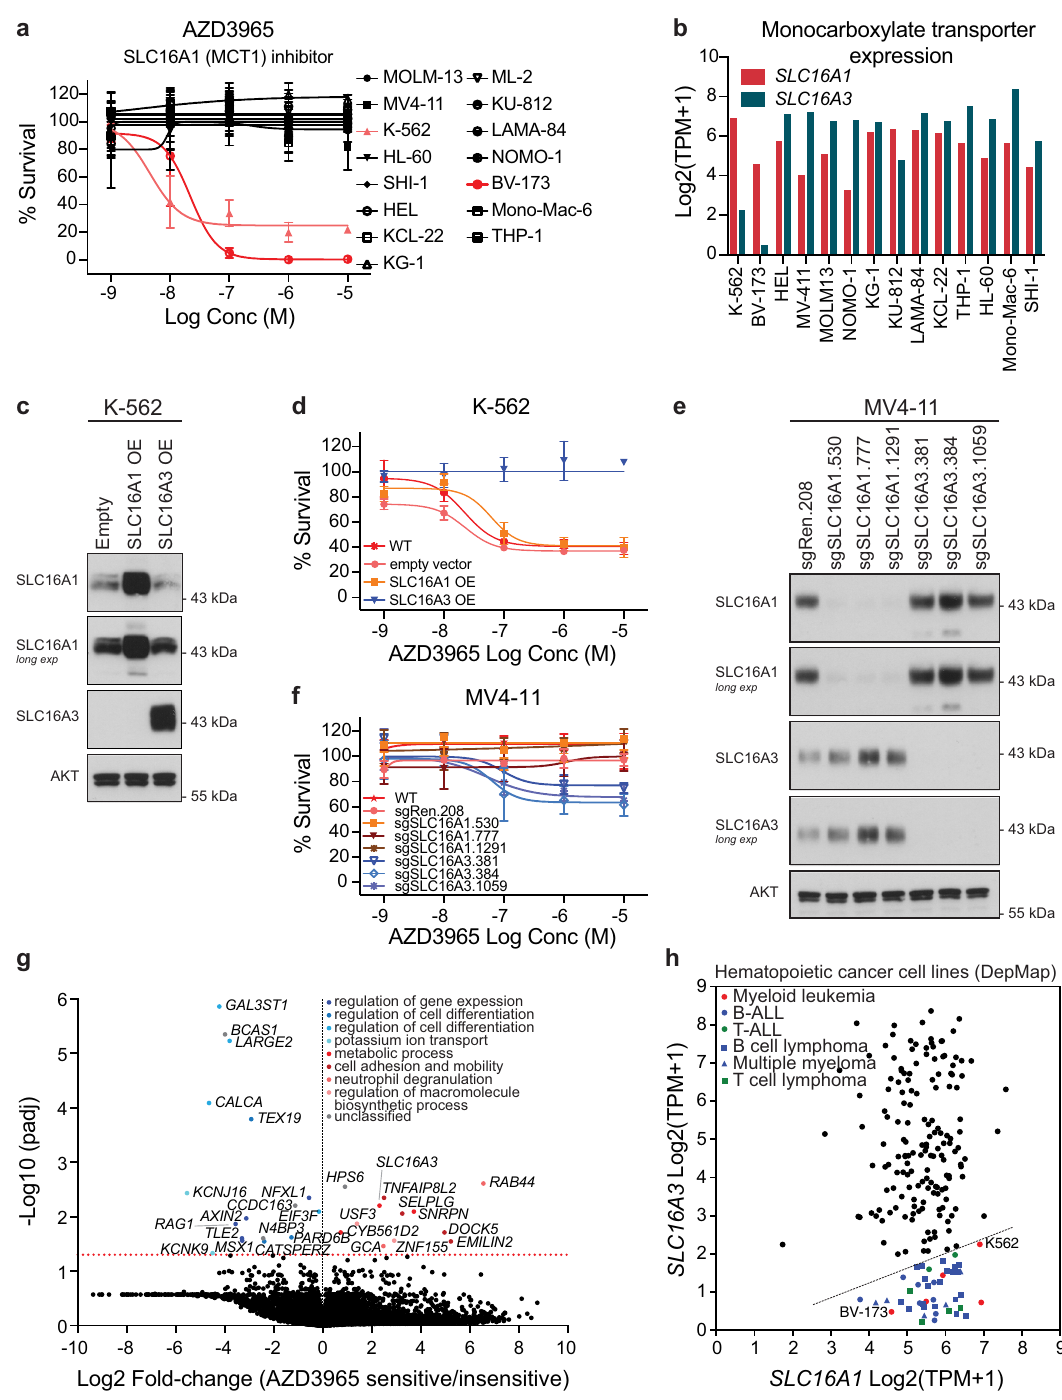
90123 BV-173 0 1